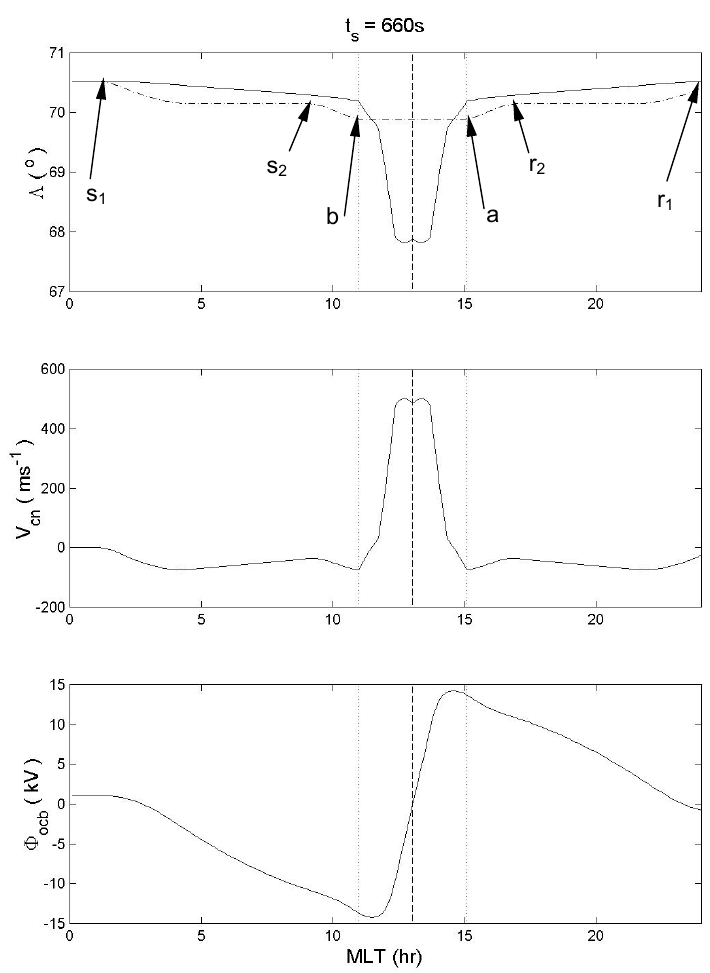
Fig. 8. Same as Fig. 4 but for simulation time t s = 660s. Note that the vertical axes scales are expanded compared to those used in Figs. 4 and